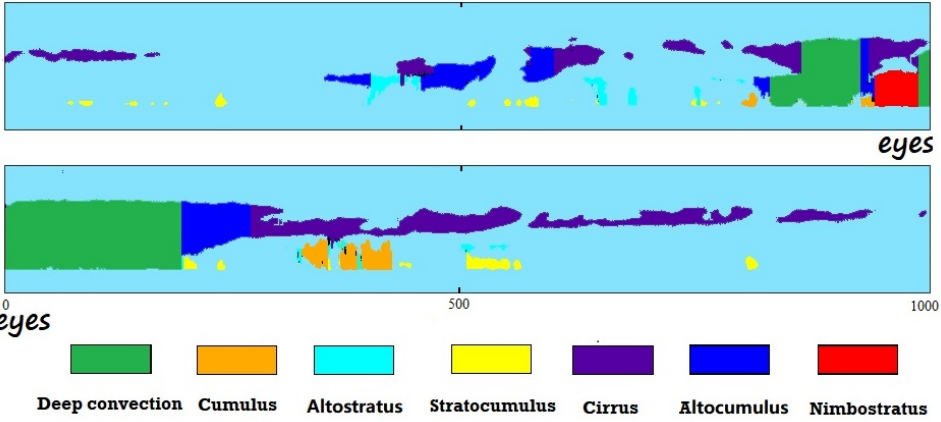
Figure 8. Cloud type distribution on the vertical section of Typhoon Nangka at 17:00 on 6 July.